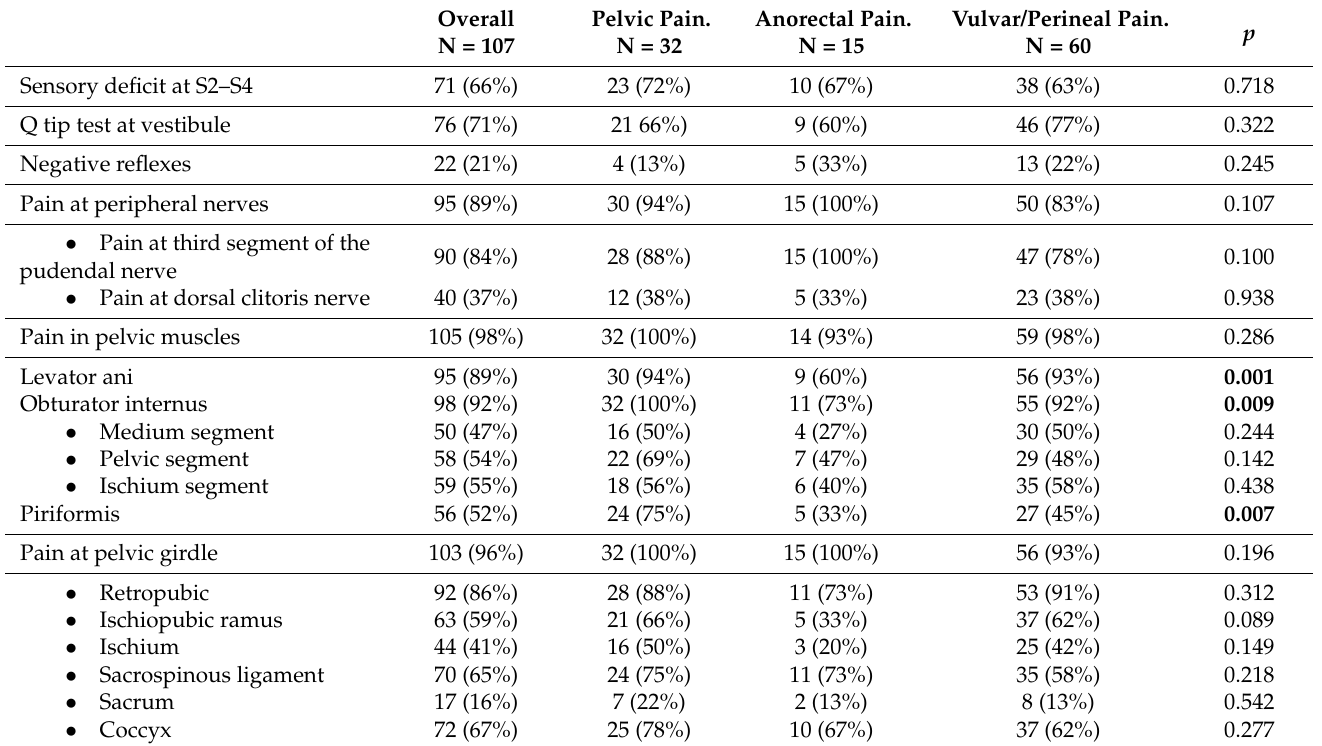
Table 2. Descriptive analyses of findings of patients with endometrioses unresponsive to conventional